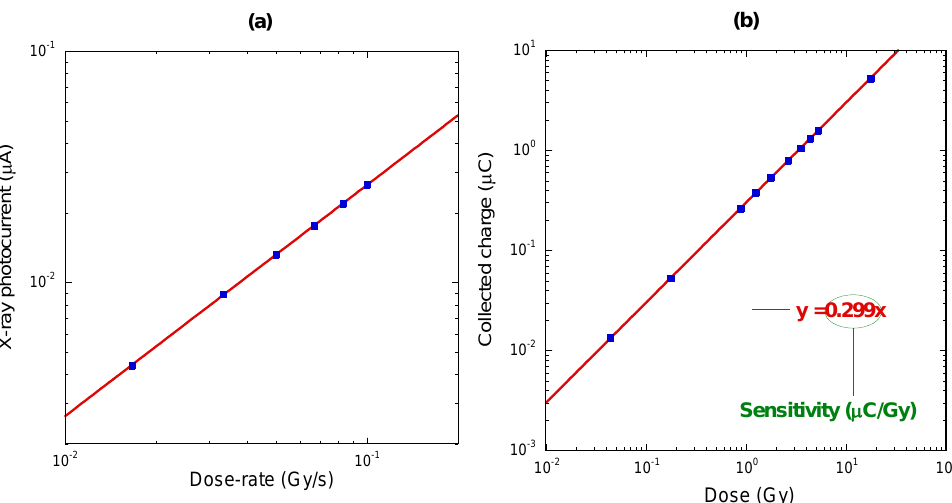
Figure 6. ( a ) Average X-ray photocurrent values as a function of the dose-rate for high-energy X-ray characterizations. Red line indicates the linear fitting curve ( ∆ = 1). Error bars, calculated as the standard deviation of the X-ray photocurrent, are smaller than the symbols; ( b ) Total collected charge as a function of the radiation dose acquired for high-energy X-ray characterizations. Red line indicates the linear fitting curve ( ∆ = 1). The delivered dose was measured by the reference ionization chamber.